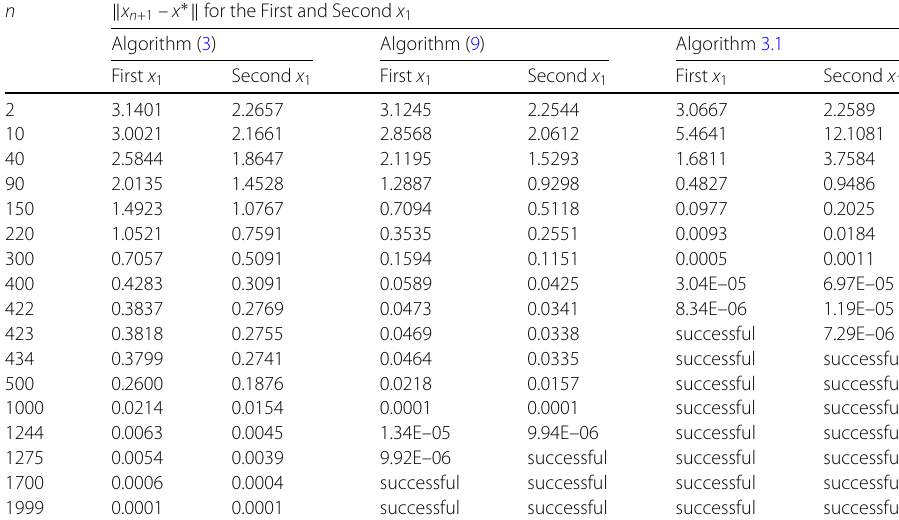
Table 2 Numerical results for the varied initial point x 1